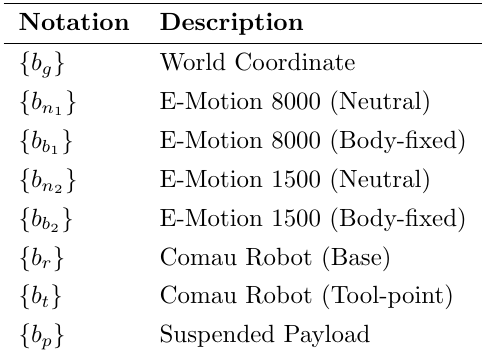
Table 4: Coordinate system annotations used for the full motion system kinematics.